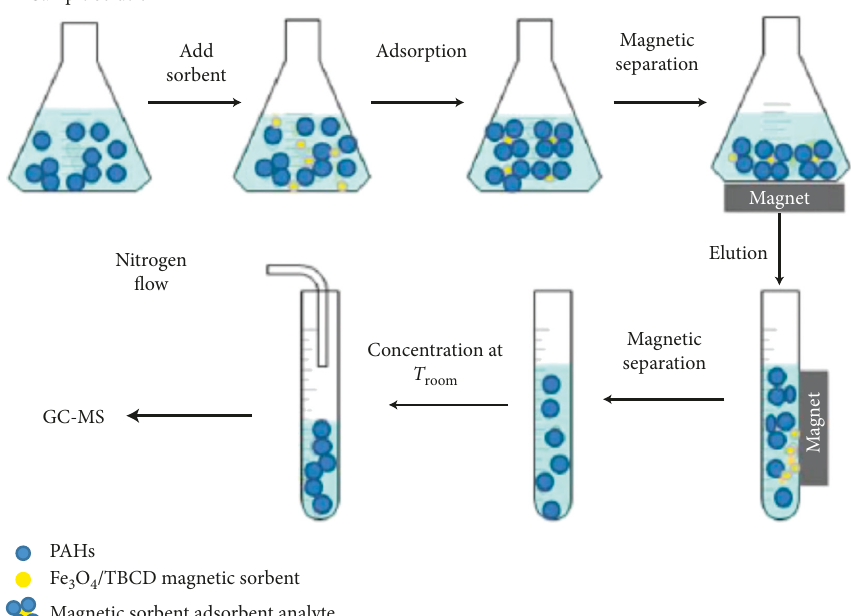
Figure 11: Scheme of the extraction process of PAHs by Fe